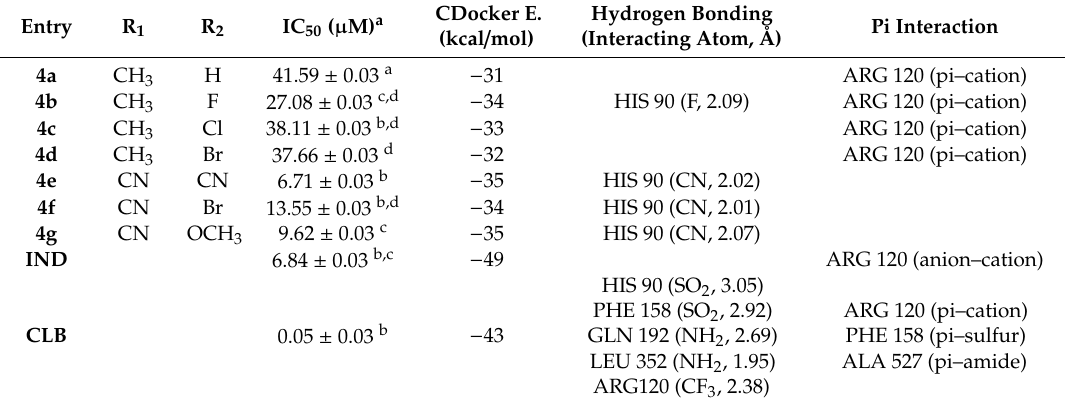
Table 4. In vitro COX-2 inhibitory activity and docking results of methyl 3-(substituted